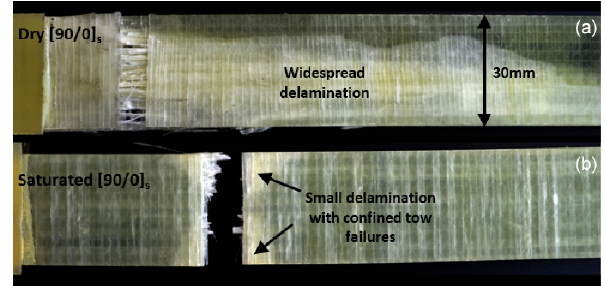
Figure 9. Failed [90/0] s coupons dry (a) saturated (b)